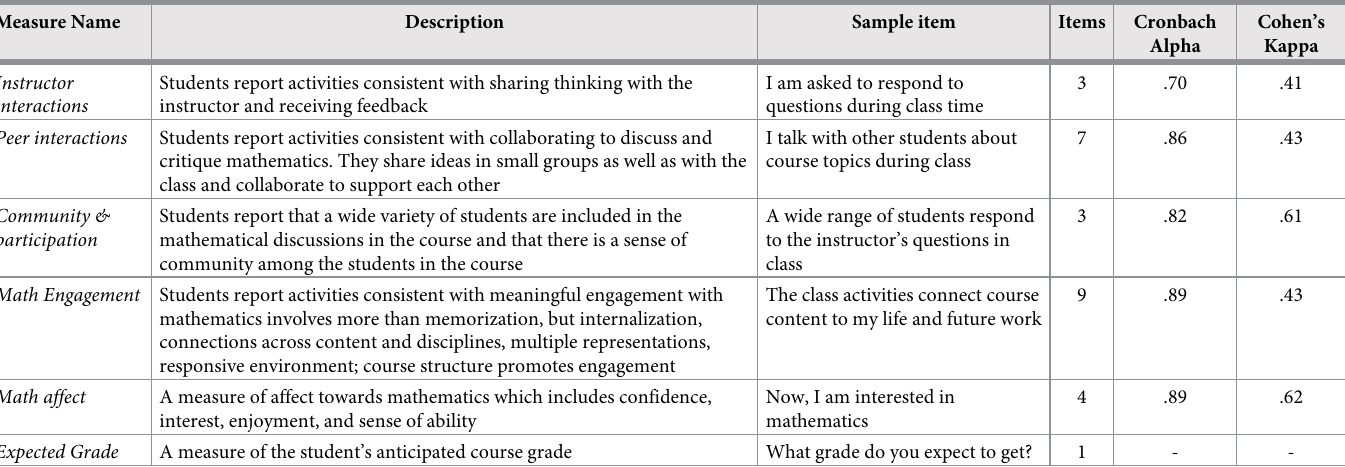
Table 1. Scale Measures and Interrater reliability scores of math instructional